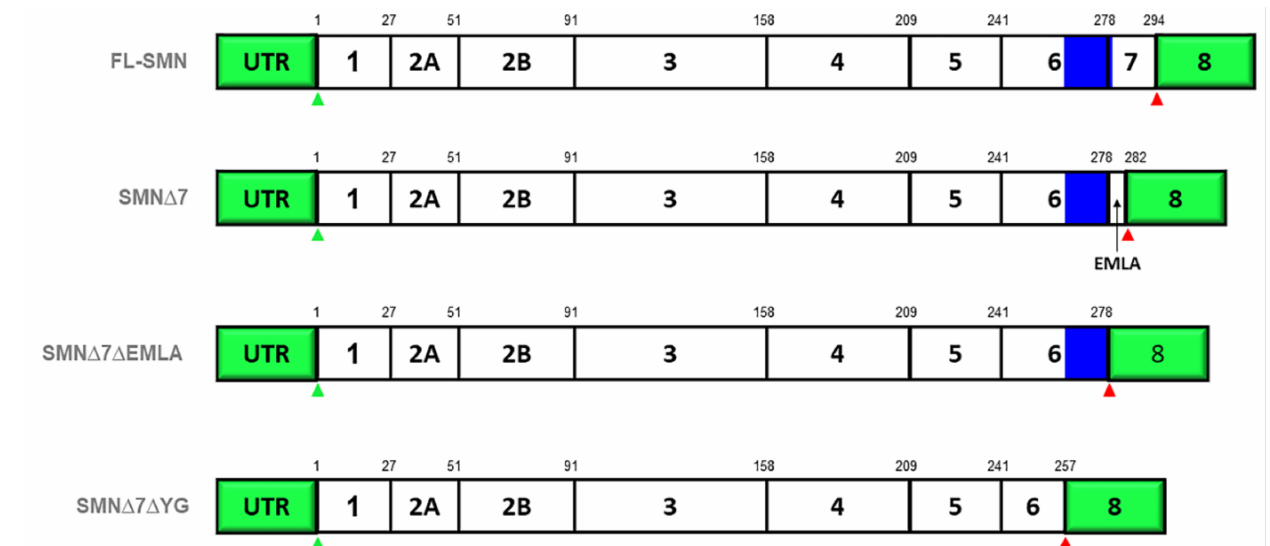
Figure 5. Schematic diagram of transcripts generated from SMN with a series of deletions. The name of the transcript is shown on the left, which indicates the deleted region. For instance, ∆ 7 refers to the deletion of exon 7. The start and stop codons are depicted in green and red triangle icons, respectively. The YG region, a conserved tyrosine/glycine rich motif, in exon 6 and 7 is indicated by the blue box while EMLA, a four-amino acids motif that replaced the 16-amino acids of exon 7, is indicated with an arrow. Abbreviation: UTR, untranslated